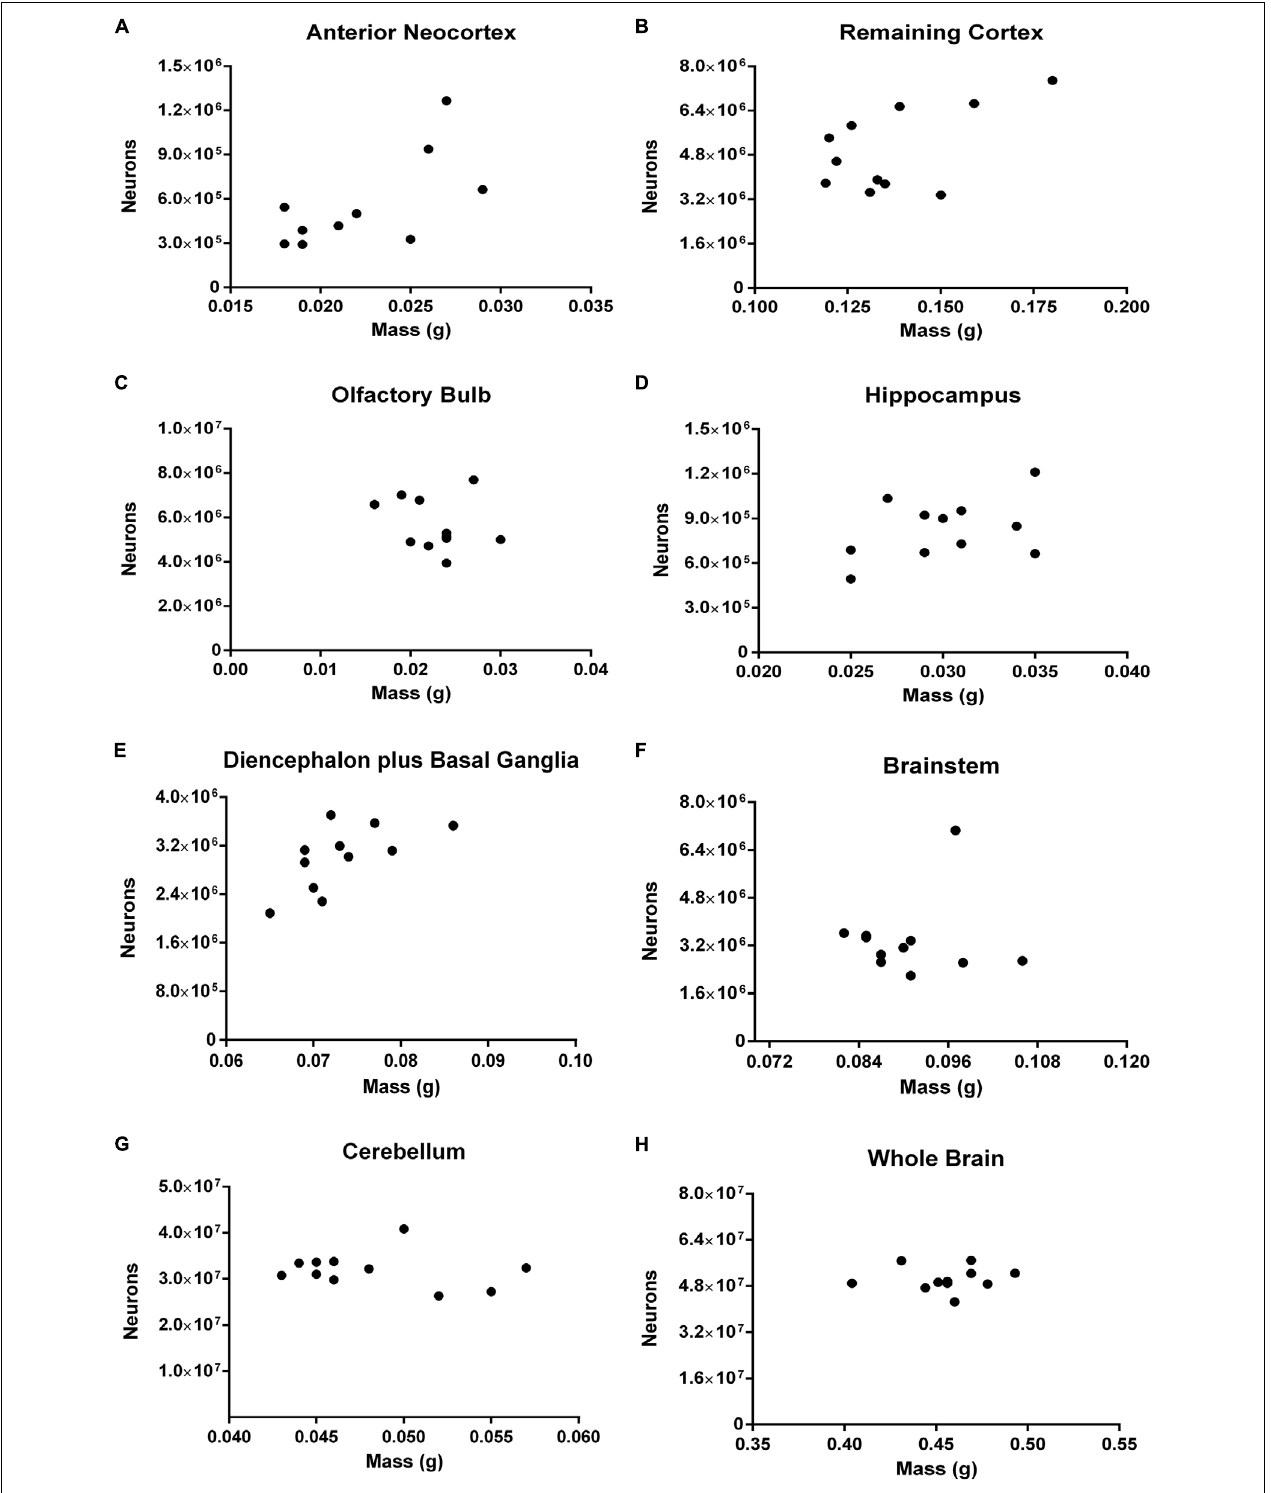
FIGURE 7 | Spearman’s correlation between the absolute number of neurons and the mass of different ROIs. Dissected regions are shown from (A–G) . The data for the whole brain is displayed in (H) . (A) Anterior Neocortex: rho = 0.5812, p = 0.0649. (B) Remaining Cortex: rho = 0.3182, p = 0.3415. (C) Olfactory Bulb: rho = –0.1535, p = 0.6020. (D) Hippocampu s : rho = 0.2615, p = 0.4419. (E) Diencephalon plus Basal Ganglia: rho = 0.5968, p = 0.0569. (F) Brainstem: rho = –0.4439, p = 0.1628. (G) Cerebellum: rho = –0.1781, p = 0.5889. (H) Whole Brain: rho = 0.1963, p = 0.5603. Each dot represents one animal ( n = 11).